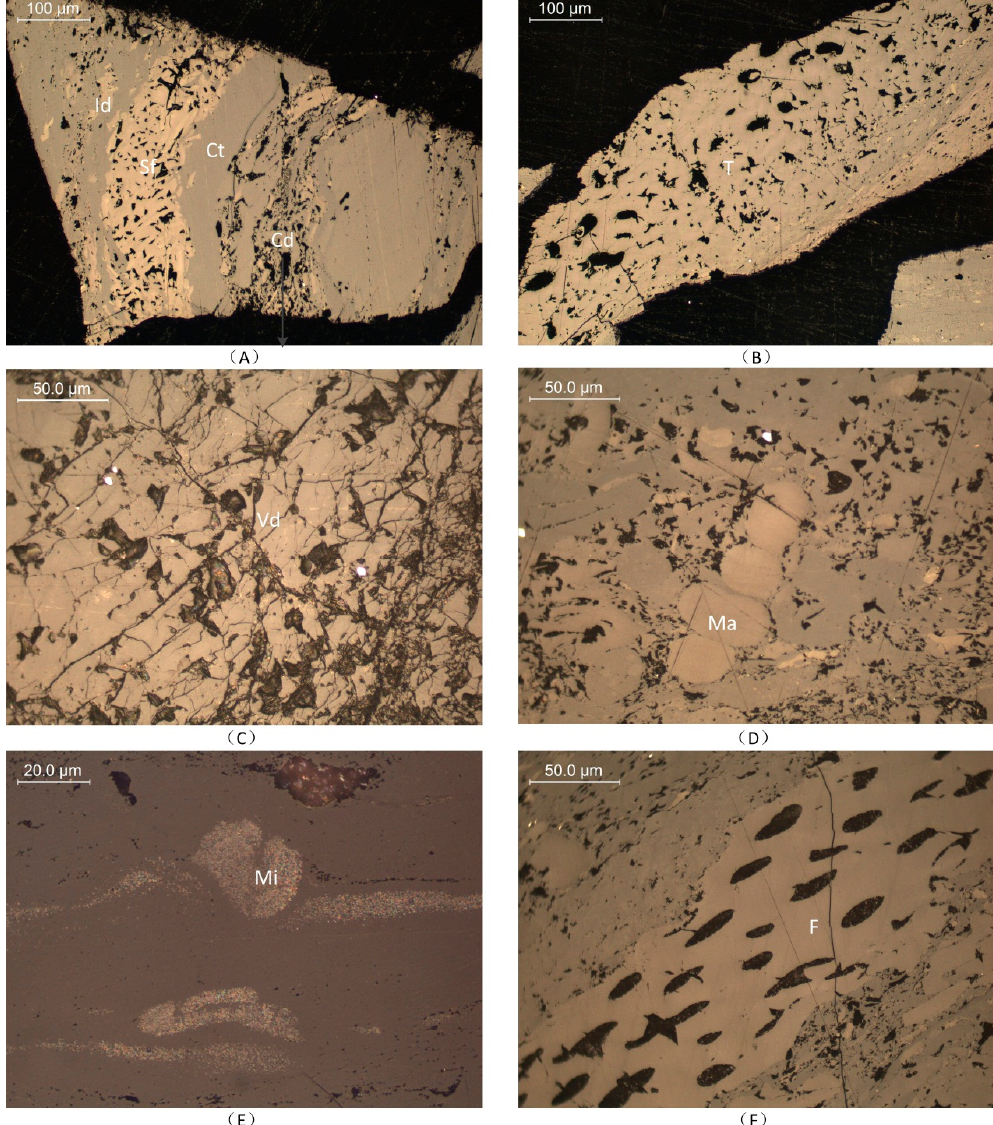
Figure 3. Macerals in the coal samples, reflected light, and oil immersion. ( A ) collodetrinite, collotelinite, semifusinite, and inertodetrinite in sample C25-1; ( B ) telinite in sample C25-2; ( C ) vitrodetrinite in sample C25-1; ( D ) fusinite with swelling cells in sample C25-3; ( E ) micrinite in sample C25-3; ( F ) macrinite in sample C25-3.